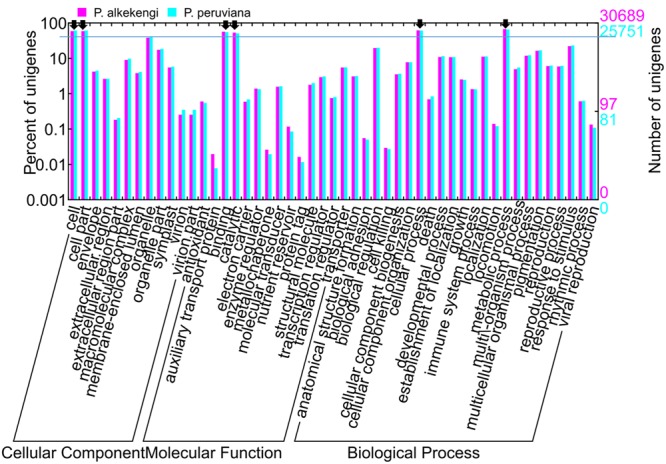
GO assignments for all assembled unigenes in P. alkekengi and P. peruviana. The results are summarized in sets of three functional categories: cellular component, molecular function, and biological process. 30,689 and 25,751 unigenes from P. alkekengi (magenta) and P. peruviana (cyan), respectively, were categorized by GO categories. The GO categories were displayed using WEGO (http://wego.genomics.org.cn; Ye et al., 2006).